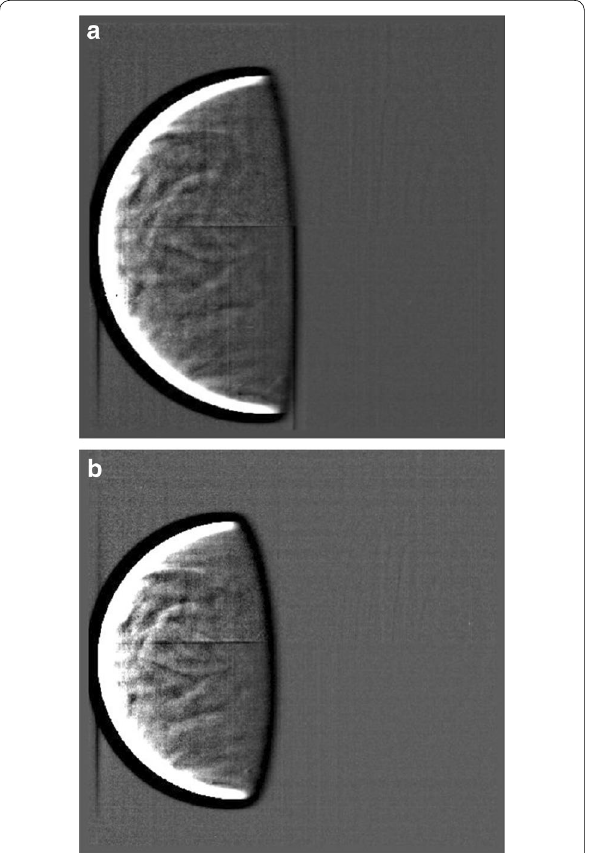
Fig. 12 a A high‑pass‑filtered Level 2 dayside image taken at 06:01 on May 07, 2016, at a distance of 75,000 km with a sub‑spacecraft latitude of 11° and a longitude of 331°. The image is not saturated − on the left limb and more detail may be recovered with a different visualization. b A high‑pass‑filtered Level 2 dayside image taken at 08:01 on May 07, 2016 (same as Fig. 4b) at a distance of 91,000 km with a sub‑spacecraft latitude of